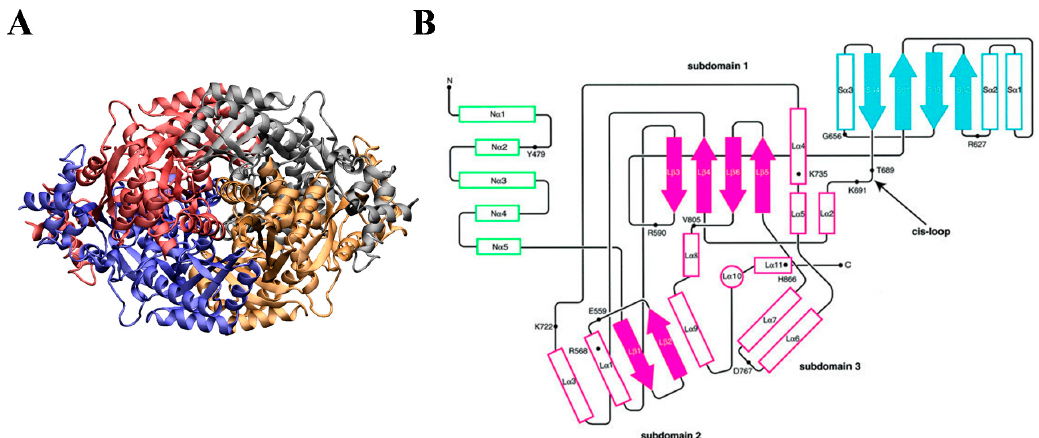
Figure 2 . Structure and topology of HMG-CoA Reductase. ( A ) Crystal structure of human HMG-CoA Reductase with each monomer of the homo-tetrameric protein shown in a different colour (red, blue, grey, orange). Images prepared with Visual Molecular Dynamics (VMD) [71] and the Protein Data Bank (PDB) structure 1HWK.pdb. ( B ) Topological structure of a human HMG-CoA Reductase monomer, with each monomer domain defined by a different colour. N-domain indicated in green; L-domain (and its subdomains) indicated in magenta; S-domain indicated in cyan. Outlined boxes represent helices, and solid arrows represent strands. N- and C-termini are indicated. Figure taken from Istvan et al., EMBO, 2000 [68], with permission from John Wiley and Sons 2020.